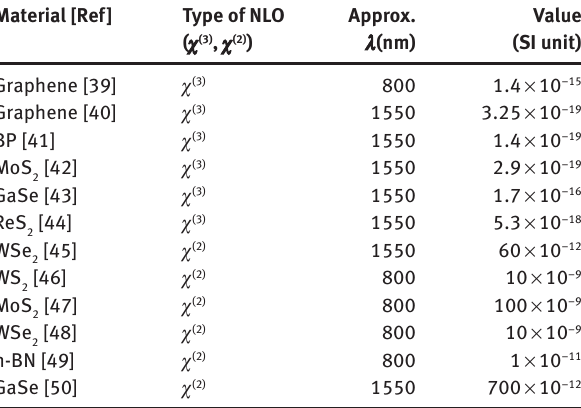
Table 1: Reported nonlinear optical coefficients in layered materials: SI unit for χ (3) -coefficients is m 2 / V 2 and for χ (2) -coefficients is m/V. Material